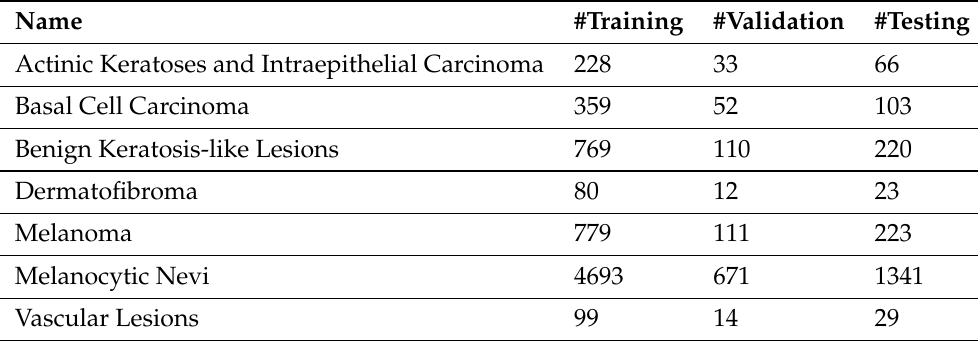
Table 3. Details of DermaMNIST dataset.